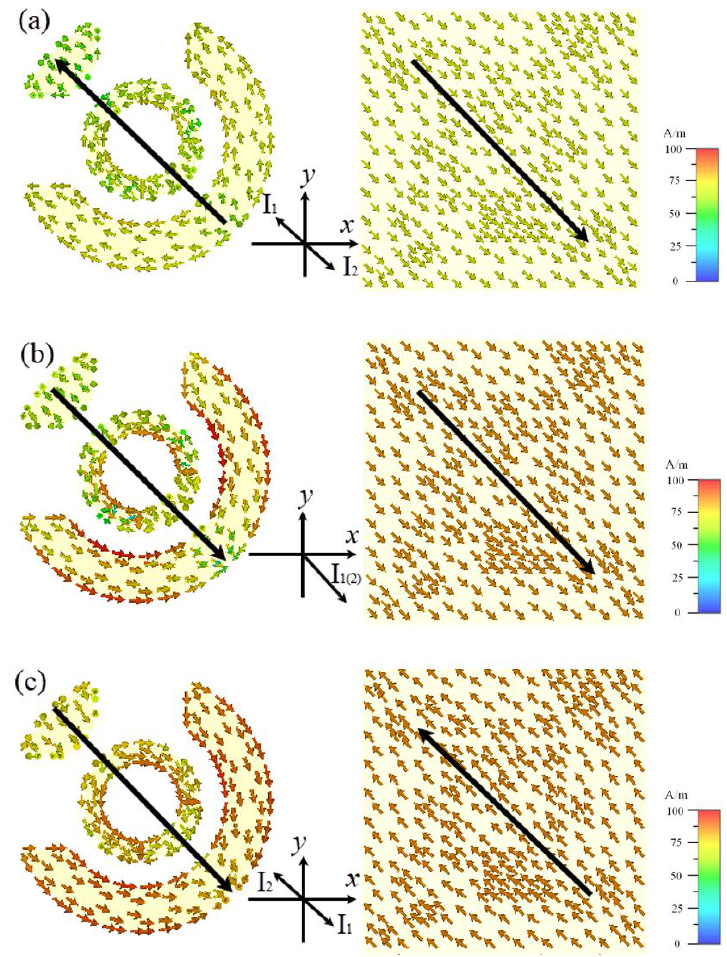
Figure 4. Surface current distribution ( a ) 15.45 GHz; ( b ) 20.82 GHz; ( c ) 26.94 GHz.